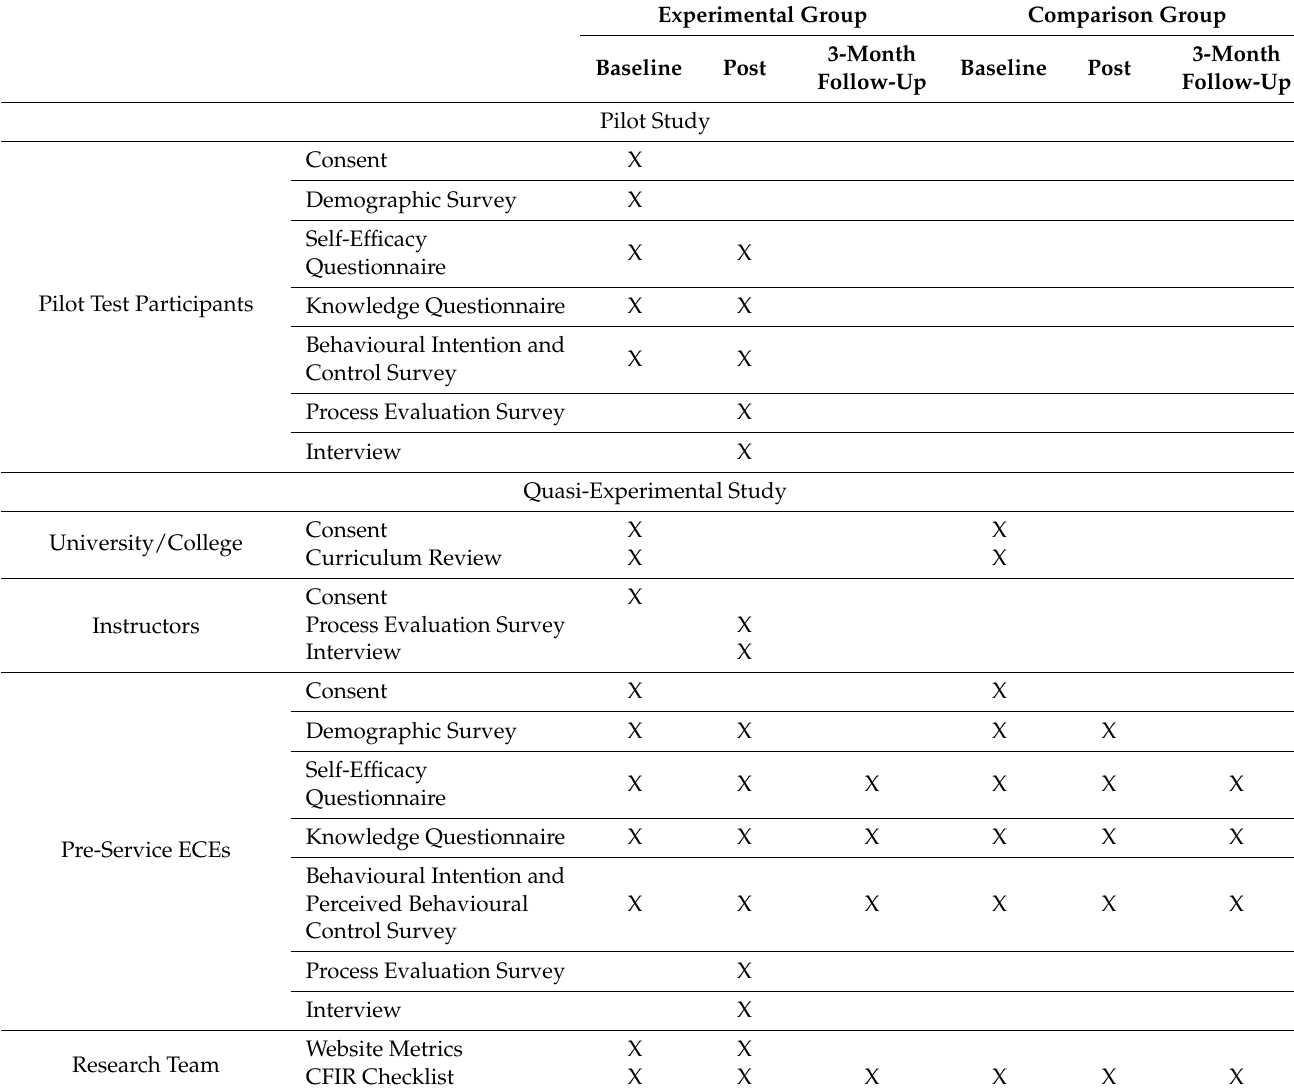
Table 1. Tools Used in the TEACH